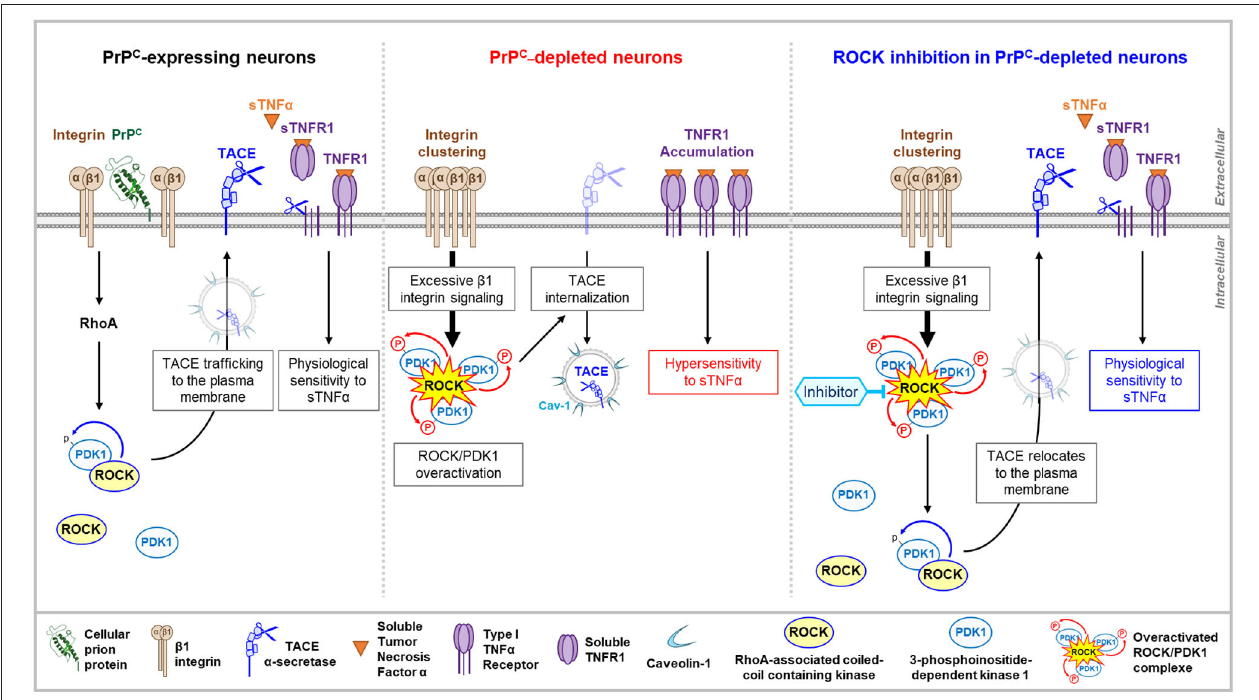
FIGURE 2 | PrP C –ROCK connection controls TACE trafficking and cell sensitivity to TNF α . By toning down the integrin-dependent RhoA activation, PrP C lowers the enzymatic activity of the ROCK/PDK1 complex that permits the α -secretase TACE to stay at the plasma membrane. TACE cleaves cell surface TNFR1 and releases sTNFR1 that neutralizes sTNF α and thereby limits the cell sensitivity to sTNF α (left) . In PrP C -depleted neurons, the overactivation of ROCK/PDK1 module provoked by the micro-clustering of β 1 integrins triggers TACE internalization and neutralization in caveolin-1 enriched vesicles. Internalized TACE is uncoupled from TNFR1 substrate that accumulates at the cell surface and renders PrP C -depleted neurons hypervulnerable to sTNF α toxicity (middle) . In PrP C -depleted neurons, pharmacological inhibition of ROCK decreases PDK1 activity, which permits TACE to locate back to the plasma membrane and to restore TACE shedding activity toward TNFR1 (right)